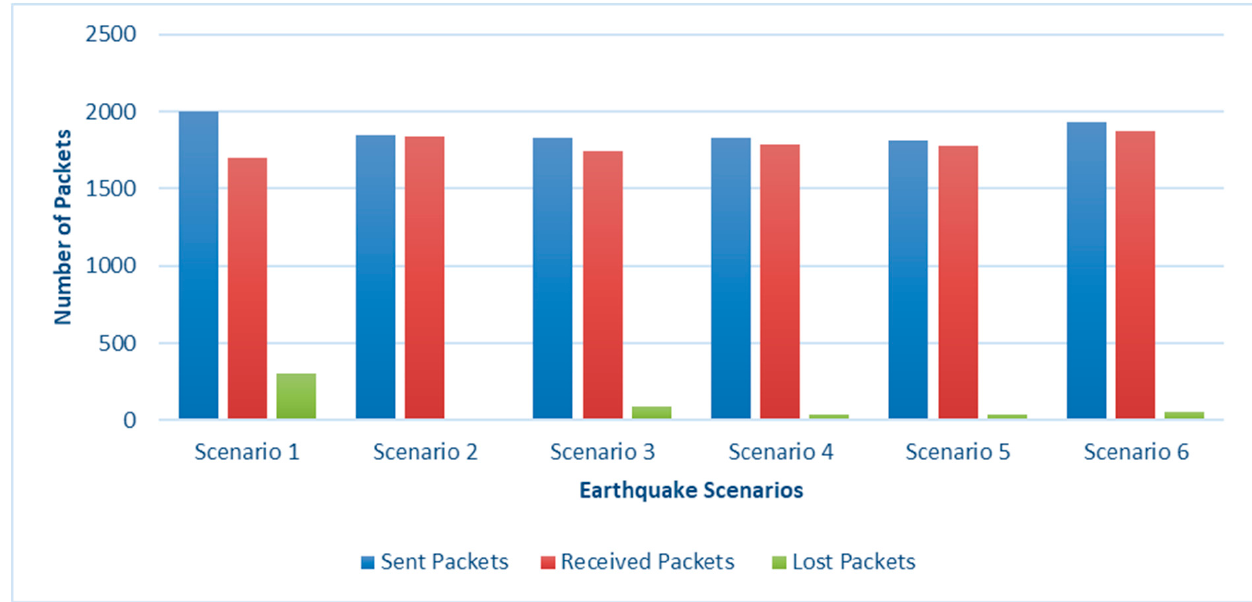
Figure 10. Lost data packets in centralised processing with MQTT as the communication protocol.